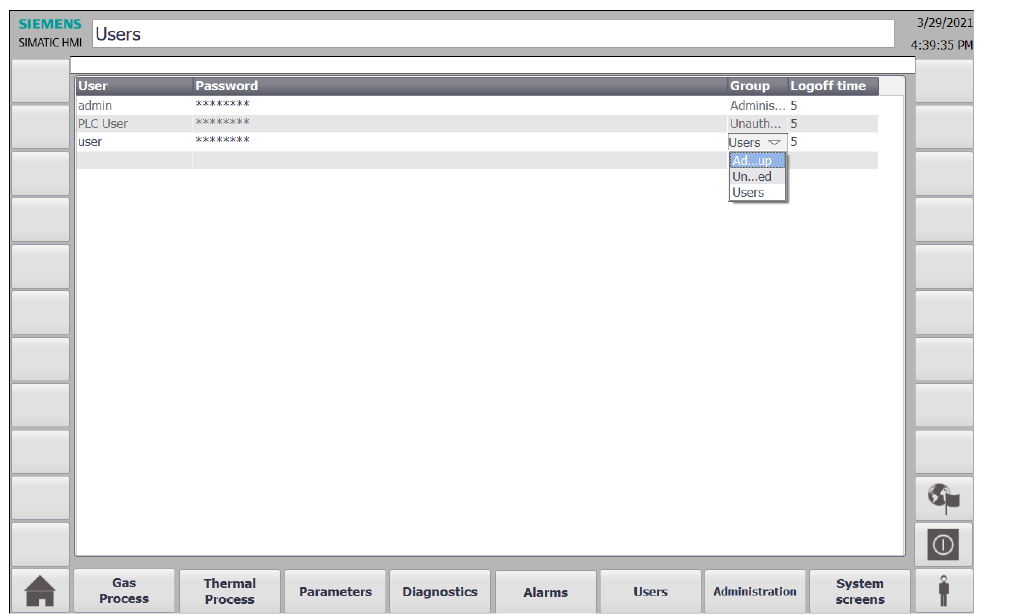
Figure 11. The digital twin SCADA gas process users